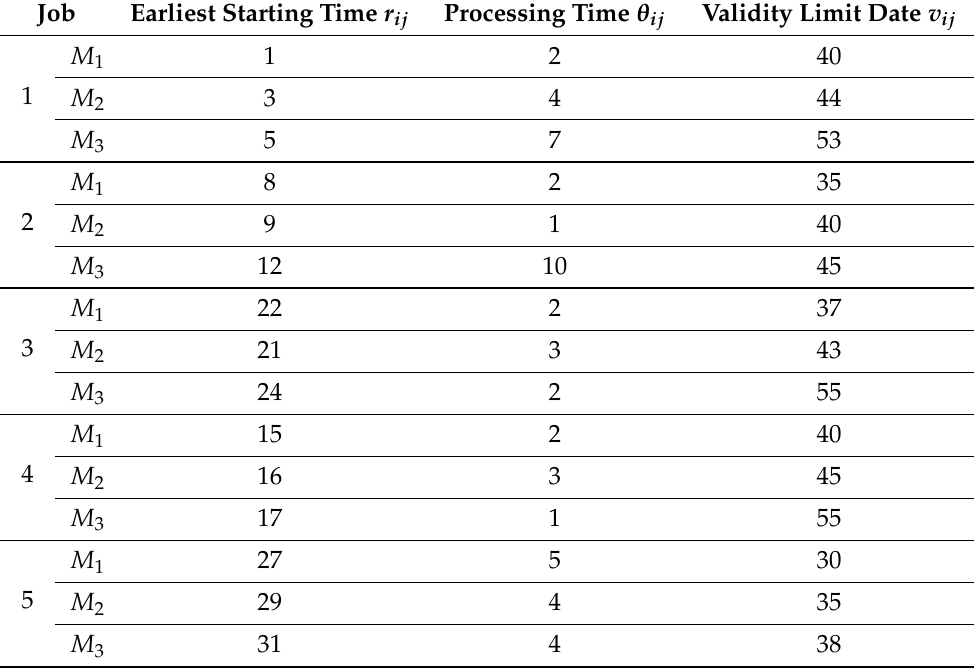
Table 1. Characteristics of the tested